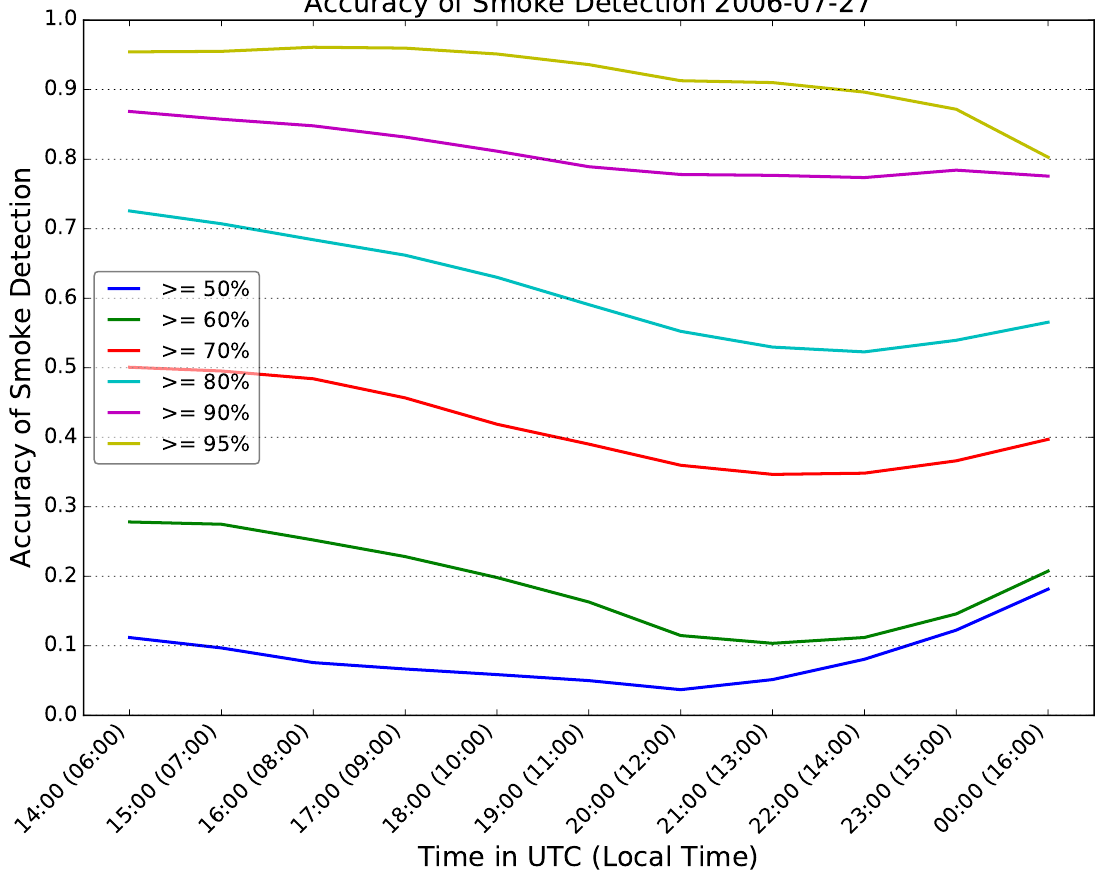
Figure 16. Accuracy of smoke detection on 27 July 2006 (solid lines). The different colored lines represent the accuracy when a “true smoke” pixel is defined by different thresholds of the contribution of smoke to the total AOD. The highest accuracy occurs when only pixels with pure smoke (>95% of total AOD coming from smoke) are considered as “true